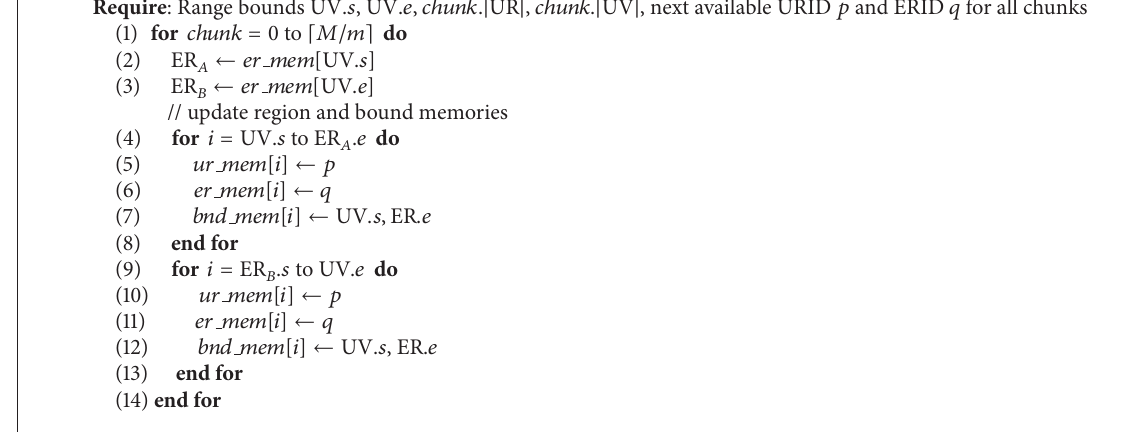
Algorithm 3: Proposed optimization for incremental update in IND.